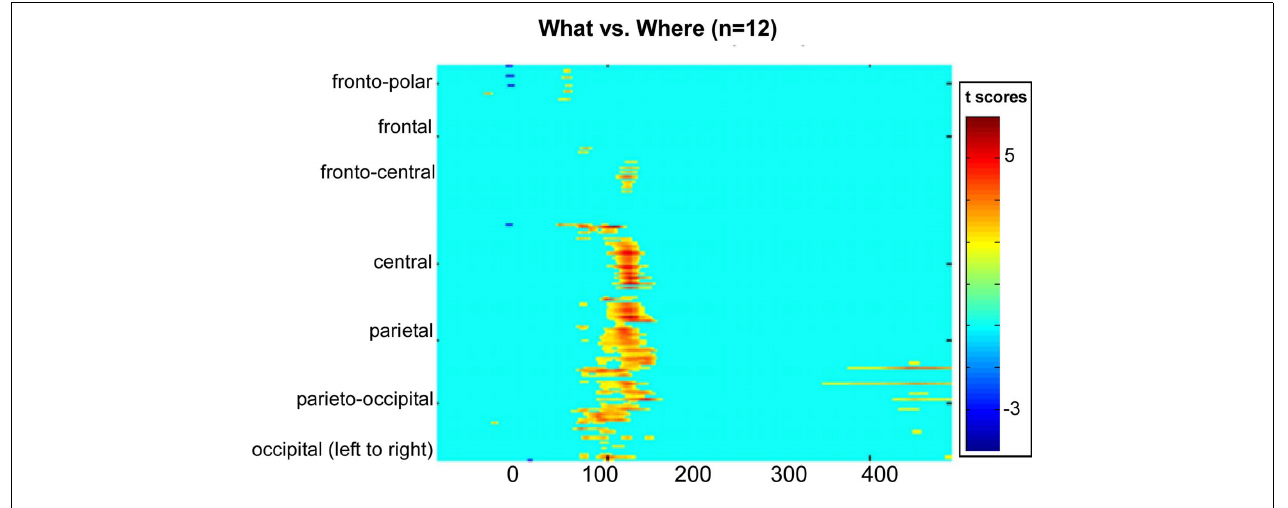
FIGURE 8 | Statistical cluster plot of the results of the point-wise running two-tailed t -tests comparing the amplitudes of participants’ auditory evoked potentials in the WHAT versus WHERE conditions. Time with respect to stimulus onset is presented on the x axis and